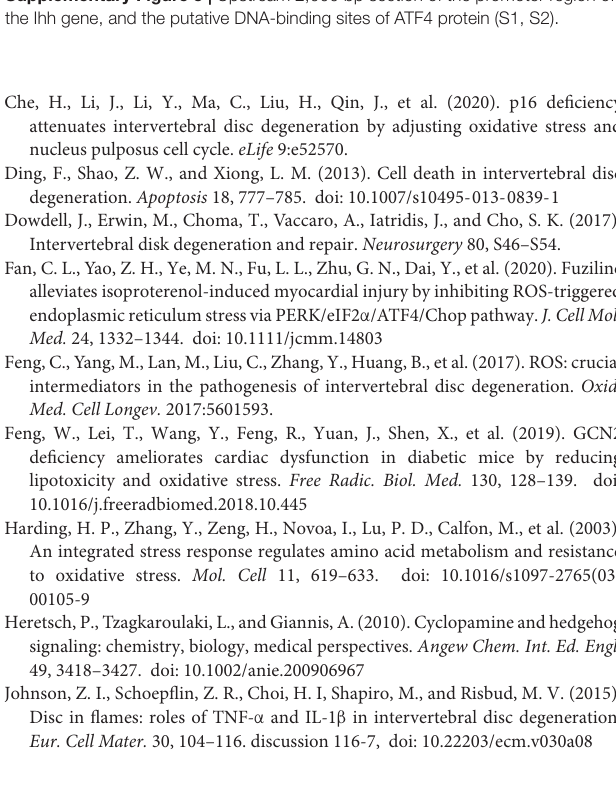
Supplementary Figure 1 | The surgical resection of mouse lumbar facet joints. (A) Exposed L3-4 level facet joints with reference to Jacoby’s line (yellow line). (B) After resection of the inferior articular process by microscissors. The yellow arrow indicates the supraspinous ligaments. (C) Mouse fur after surgery. Supplementary Figure 2 | The intervertebral disc height index (DHI) was calculated by 2 × (height of the posterior + middle + anterior parts of the disc)/(height of the posterior + middle + anterior parts of the two adjacent vertebral body). Supplementary Figure 3 | Representative magnetic resonance imaging (MRI) scans of patients with different categories of disc degeneration, according to Pfirrmann grade. G1 from the spine fracture, G3, G5 from the lumbar disc herniation. The yellow arrow indicates the surgical site. Supplementary Figure 4 | The efficiency of the siRNA transfection targeting ATF4. NP cells were transfected with the siATF4 or NC-siRNA, and the cells without transfection were set as control. (A) ATF4 protein levels were assessed by WB, measured by densitometric analyses and (B) expressed as folds relative to control. The siRNA transfection was over 80%. Data are presented as the means ± SD ( n = 3) ( ∗∗∗ p < 0.001). Supplementary Figure 5 | Upstream 2,000 bp section of the promoter region of the Ihh gene, and the putative DNA-binding sites of ATF4 protein (S1,